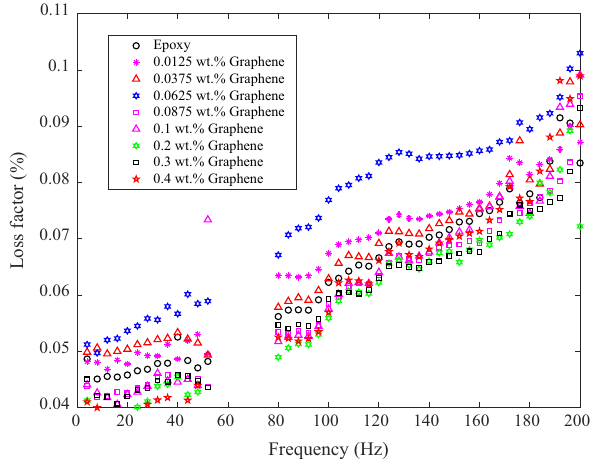
Figure 8: Frequency - dependent loss factor of GNP - reinforced com - posites by DMA tests.